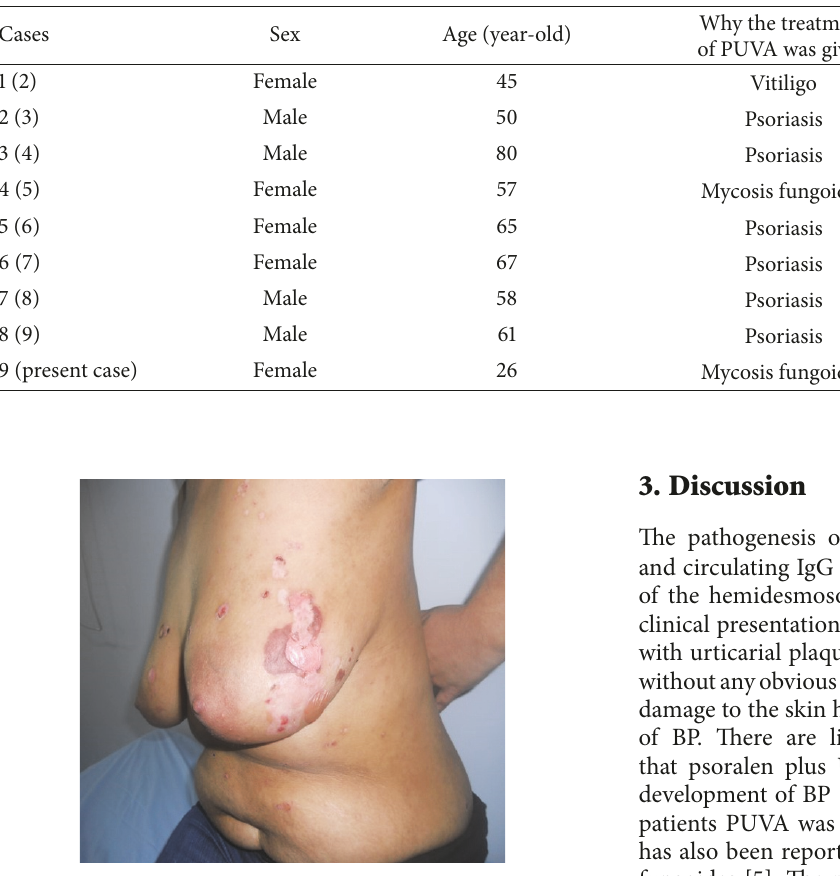
Table 1: Cases of BP due to PUVA therapy.